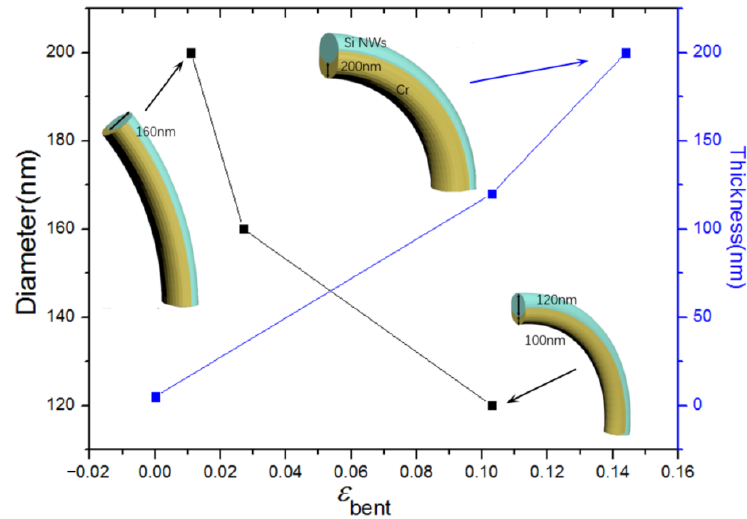
Figure 1. Si NWs prepared by asymmetric deposition with different bent strain ε Bent.